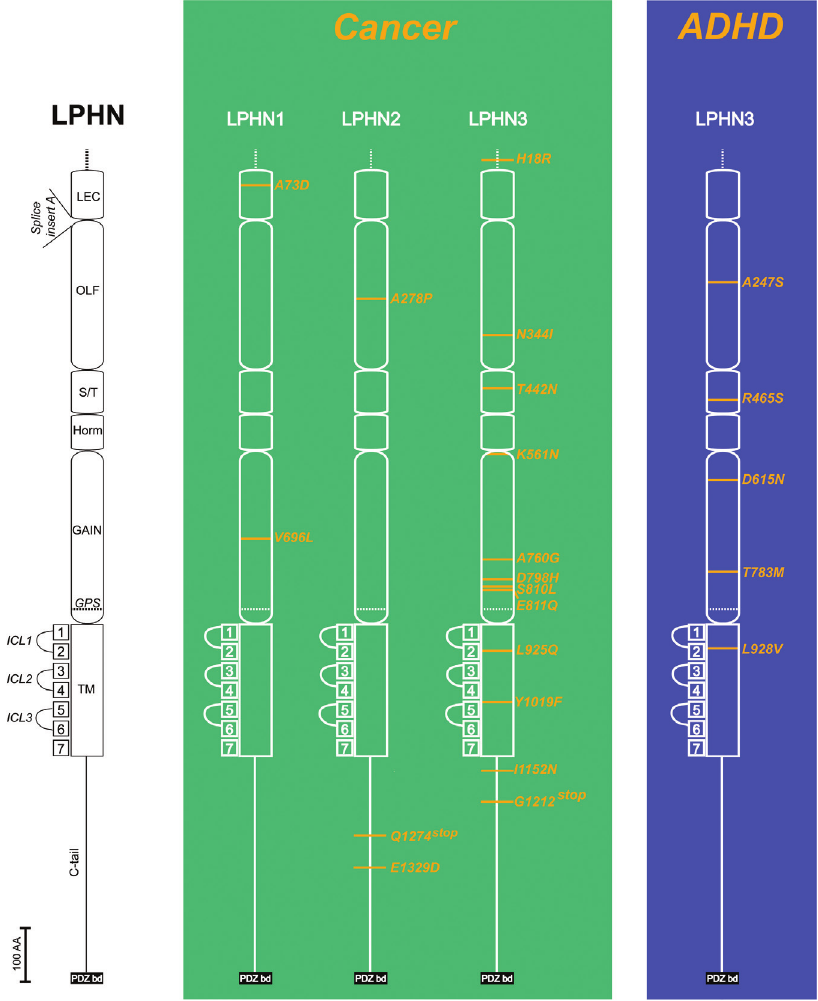
Figure 3 Missense mutations identified for latrophilins in human cancer samples and patients diagnosed with ADHD. Schematic representation of LPHN and their structural domains: LEC, lectin-like domain; OLF, olfactomedin-like domain; Horm, hormone- binding domain; S/T, serine/threonine-rich domain; GAIN, GPCR autoproteolysis inducing domain; GPS, GPCR proteolysis site; TM, seven- transmembrane domains region (1–7); C-tail, carboxy-terminal tail; PDZ bd, PDZ-binding domain. Missense mutations are shown for each LPHN (LPHN1, 2, and 3) and identified by a positioning number, which is adjacent to the affected structural domain in the immature proteins (containing the signal peptide, which is represented by a dashed line). Note that all three LPHN have mutations linking them to cancer, but only LPHN3 has been identified as a molecular target for mutations affecting the development or susceptibility to ADHD. The majority of identified missense mutations in all LPHN are clustered in their extracellular domains, the GAIN domain being the most targeted for LPHN3 in either cancer or ADHD